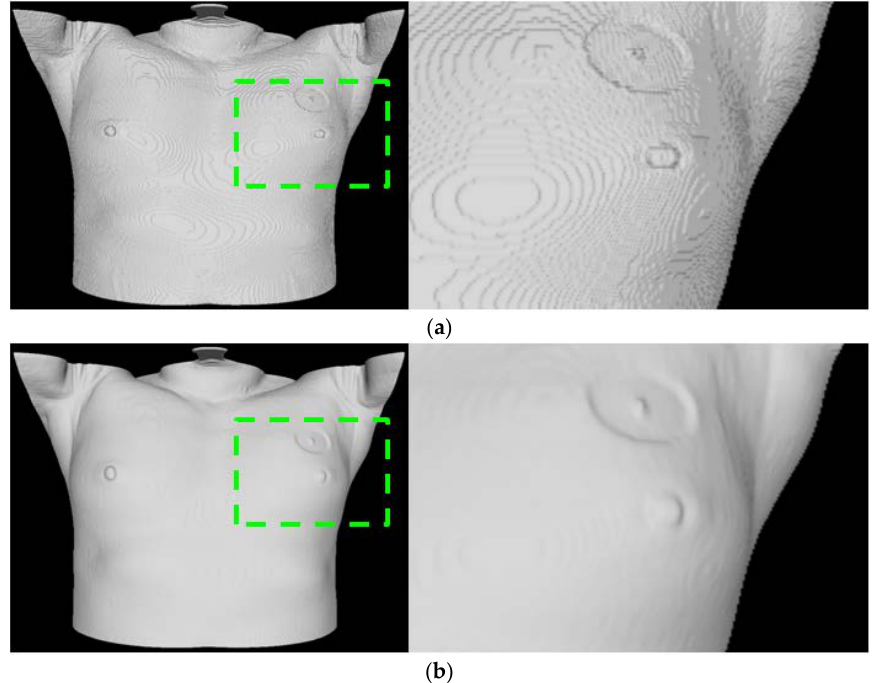
Figure 2. Results of skin mesh generation. ( a ) Skin mesh generated using Marching Cube algorithm. ( b ) Results obtained by application of Gaussian filtering and decimation.